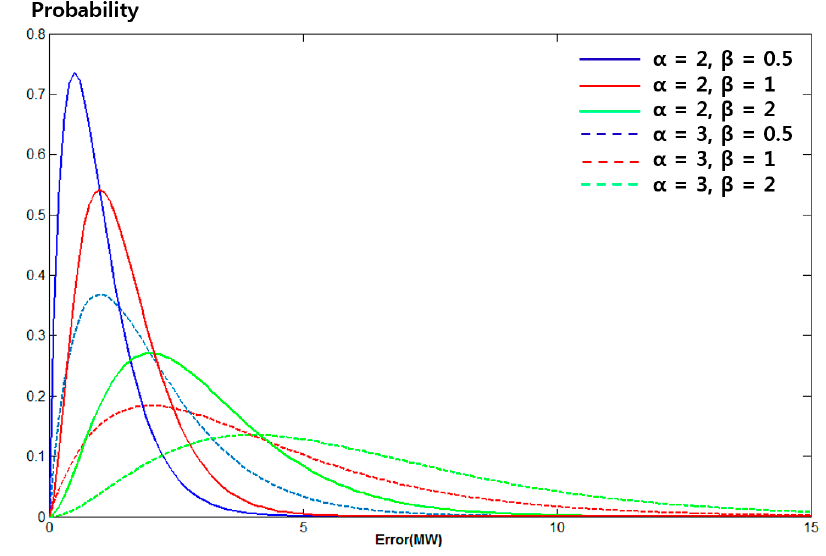
Figure 3. Gamma-like density functions with various α and β .